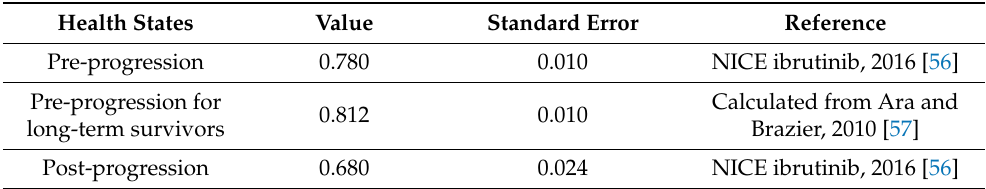
Table 3. Estimated utility values from literature used in model base